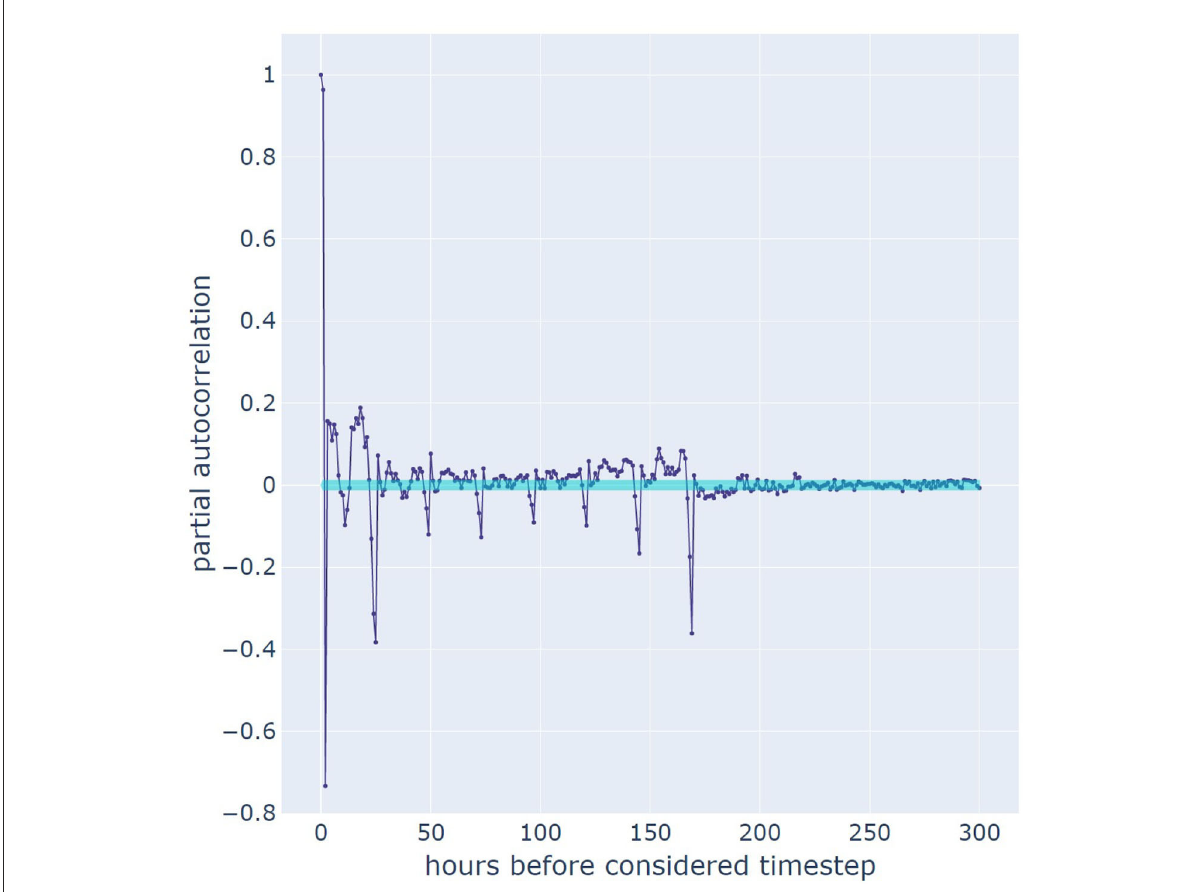
FIGURE3 Partial auto-correlation function of the Climate change total impact time series. X -axis represents the hours that precede the hour where the forecasting for the following day is performed. The area highlighted in light blue represents the interval where the auto-correlation of the signal is not considered